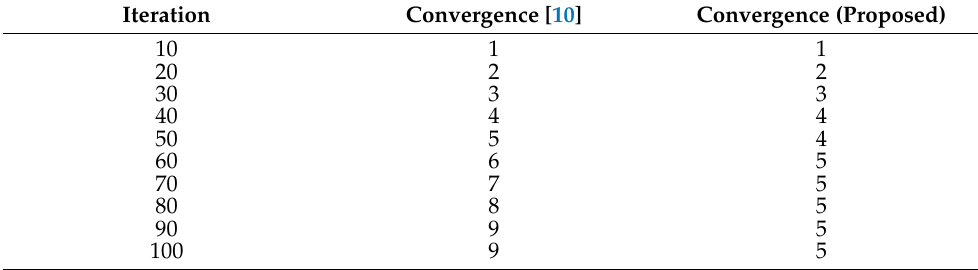
Table 7. Convergence characteristics.